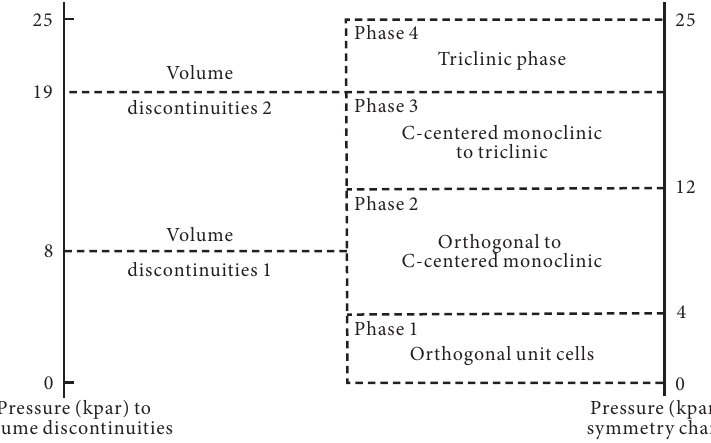
Figure 2: The structural variation of analcime with